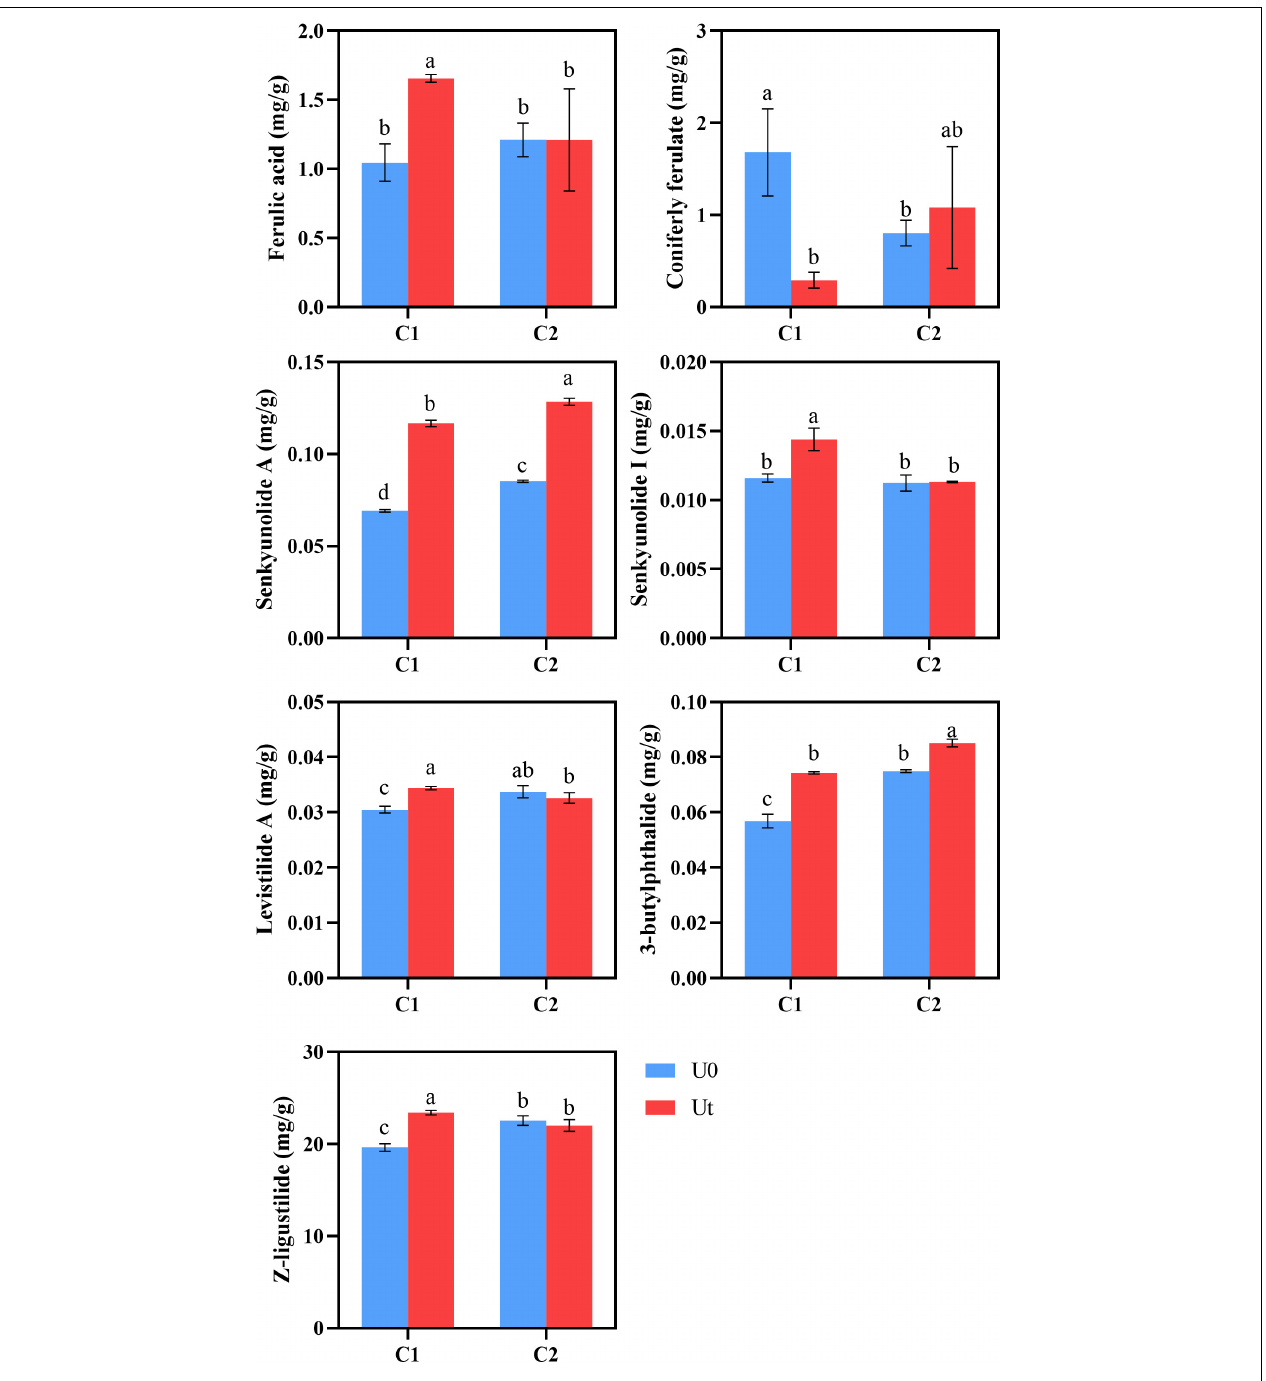
FIGURE 6 | Levels of bioactive compounds of two RAS cultivars in response to enhanced UV-B radiation. Different letters indicated the significant difference ( P < 0.05). Error bars were represented standard deviation (SD). overall the number of downregulated genes was much lower than pathways in C2. In C1, under UV-B enhanced radiation, most in C1 ( Figure 9B ). Among the photosynthetic-related pathways of the nine coding DEGs of the key enzymes rbcL , rbcs , PGK , in KEGG, only the photosynthetic antenna protein pathway was GAPDH, and GAPA in the photosynthetic biological carbon significantly downregulated in C1 ( Figure 9C ). However, there fixation pathway were down-regulated. In C2, the expression of is no significant enrichment of photosynthetic system related related genes in the photosynthetic system is stable ( Figure 9D